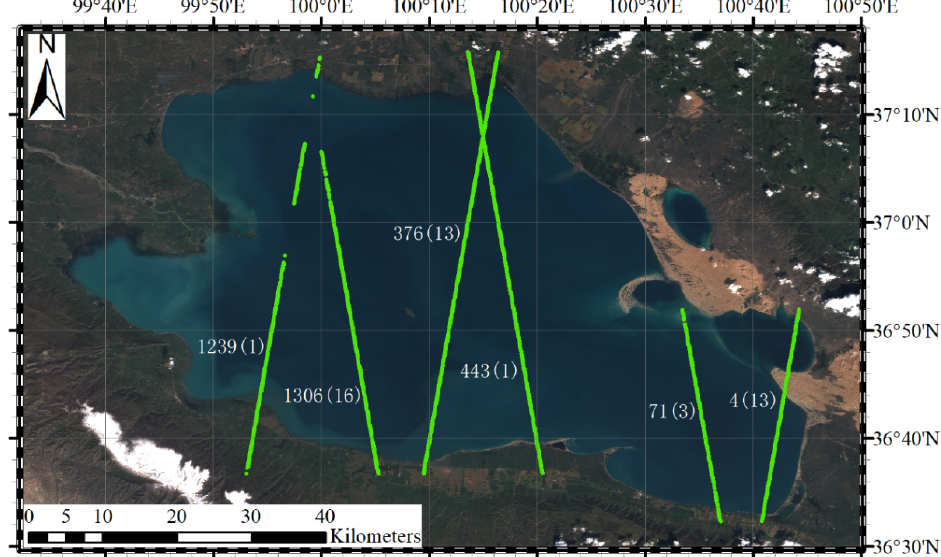
Figure 2. The track ID and the corresponding number of days of the ICESat along-track pass over Qinghai Lake (note: this figure is created using Sentinel-2 data). Table 3. The track ID and its corresponding dates for the ICESat along-track pass over Qinghai Lake. Track